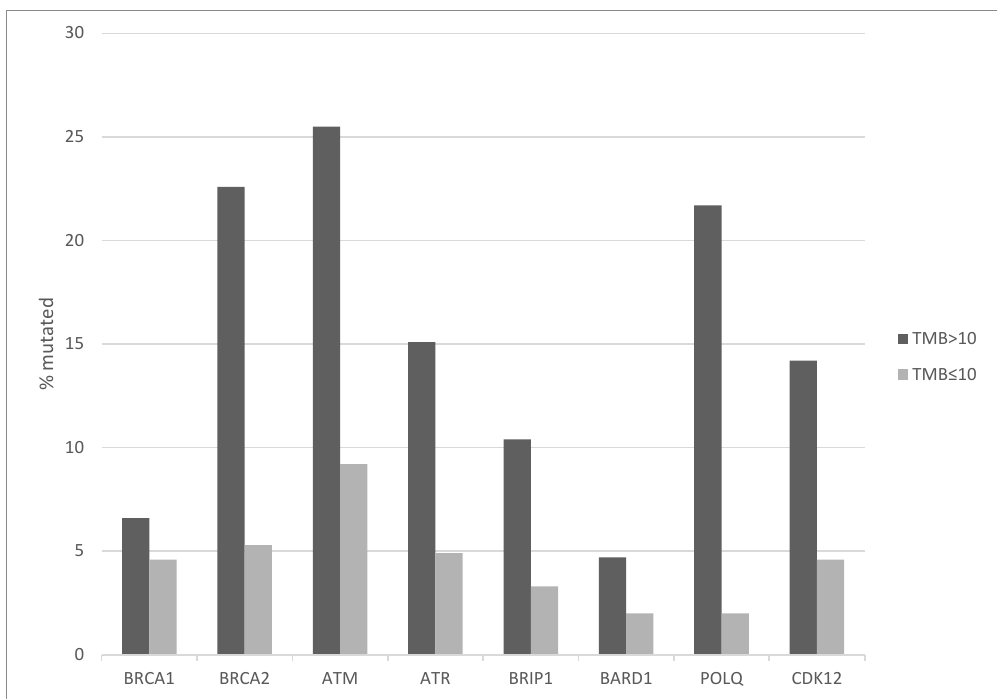
Figure 3. Prevalence of mutations in DNA Damage Response related genes in bladder carcinomas according to TMB groups. High TMB group: TMB > 10 mutations/MB, low TMB group: TMB ≤ 10 mutation/MB. TMB: Tumor Mutation Burden.